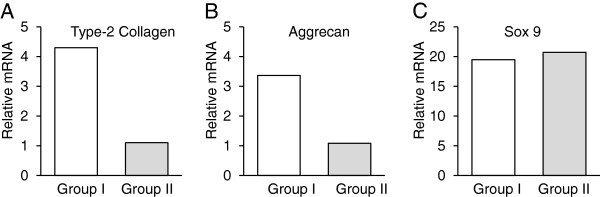
Real-time PCR analysis on gene expression of type-2 collagen, aggrecan, and SOX9 at 12 weeks. mRNA expression of type-2 collagen (A) and aggrecan (B) of Group I was 5 times and 3 times, respectively, as much as that of Group II. SOX9 (C) was highly expressed in both Groups I and II to the same degree.